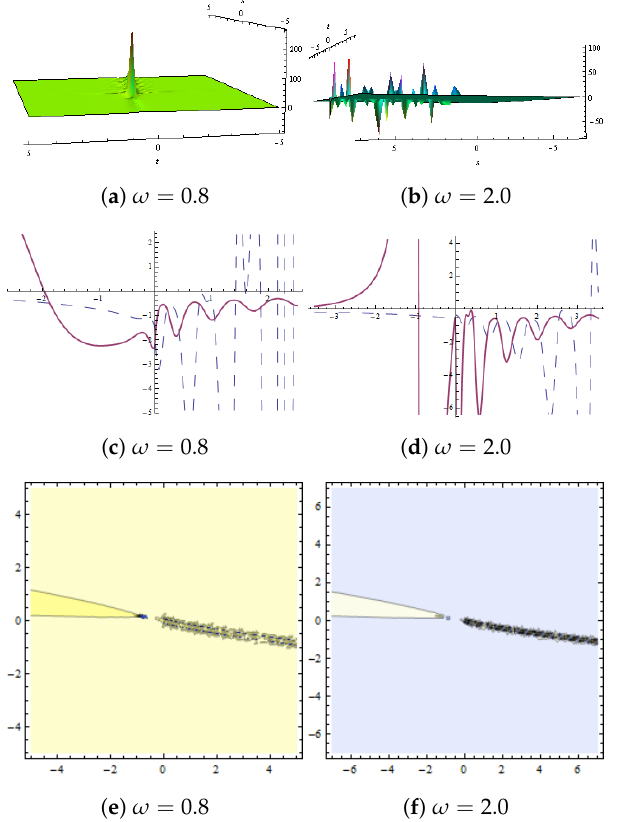
Figure 17. Dynamical demonstration of u ( x , t ) in Equation (44) presented with β 1 = 1.3, β 2 = 0.2, β 3 = 3.5, β 4 = 0.4, ζ = 0, l 2 = 0.1, l 5 = 0.5, Q = 3.2, r 1 = 2.5, w 2 = 2, w 3 = 3.5, w 5 = 1.5, and φ = 5.4. ( a , b ) show 3D graph of lump wave, ( c , d ) represent 2D graph and ( e , f ) show contour